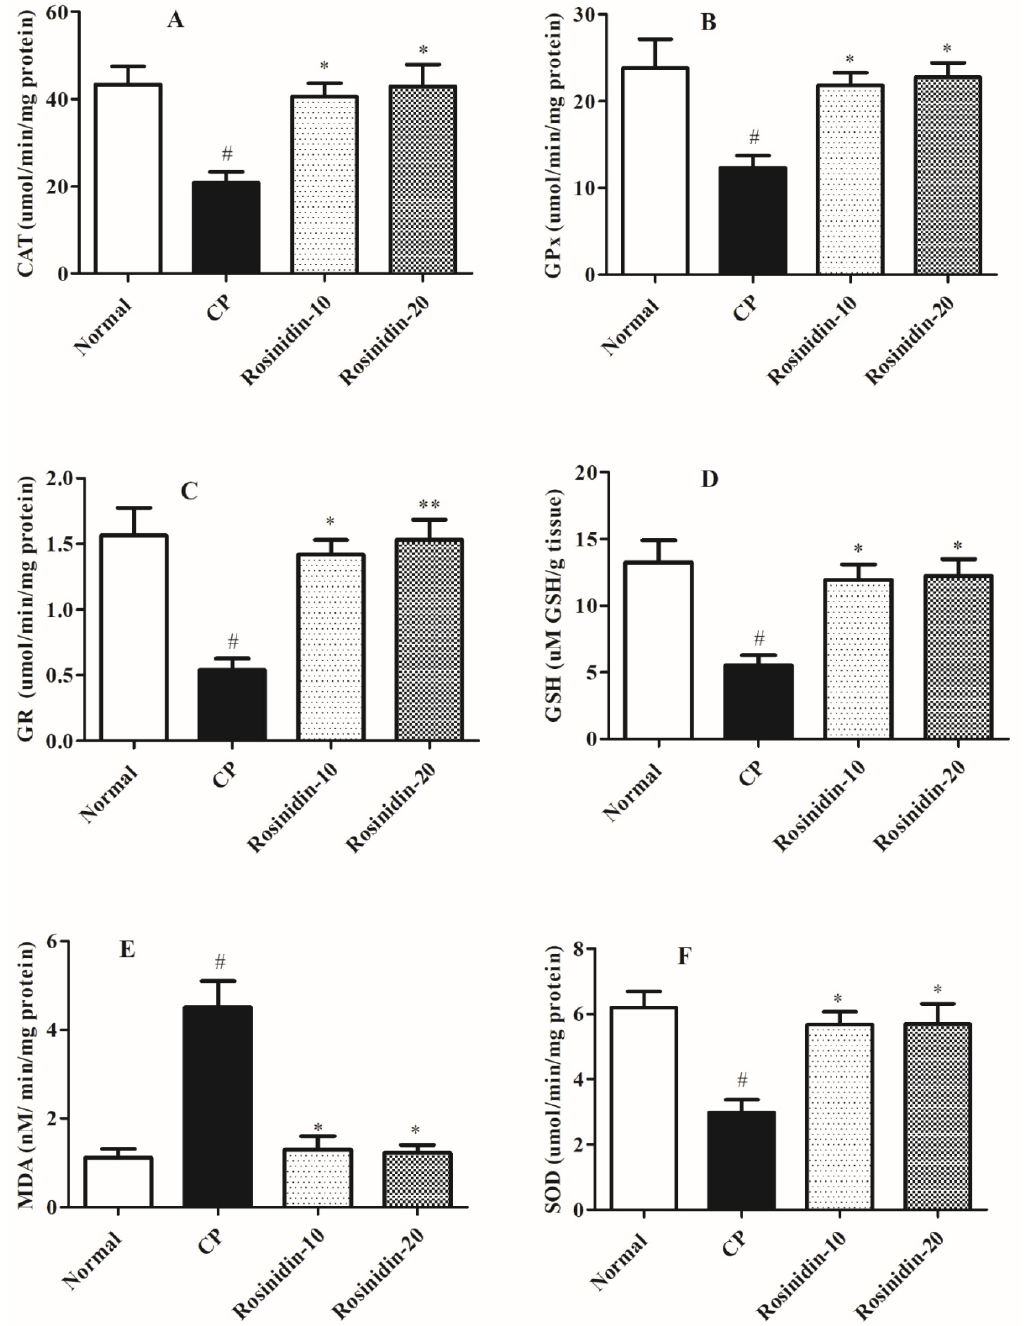
Figure 3. Effect of rosinidin on levels of enzymatic and non-enzymatic parameters against cis-platin-induced nephrotoxicity in rats. ( A ) CAT ( B ) GPx ( C ) GR ( D ) GSH ( E ) MDA ( F ) SOD; Data were presented as mean ± SEM ( n = 6). # Indicate significant alteration for normal vs. control; ** p < 0.01, * p < 0.05 indicated modulations observed in rosinidin vs. cisplatin. p value less than 0.05 were considered statistically significant. The analysis was carried out by employing the Kruskal–Wallis test.